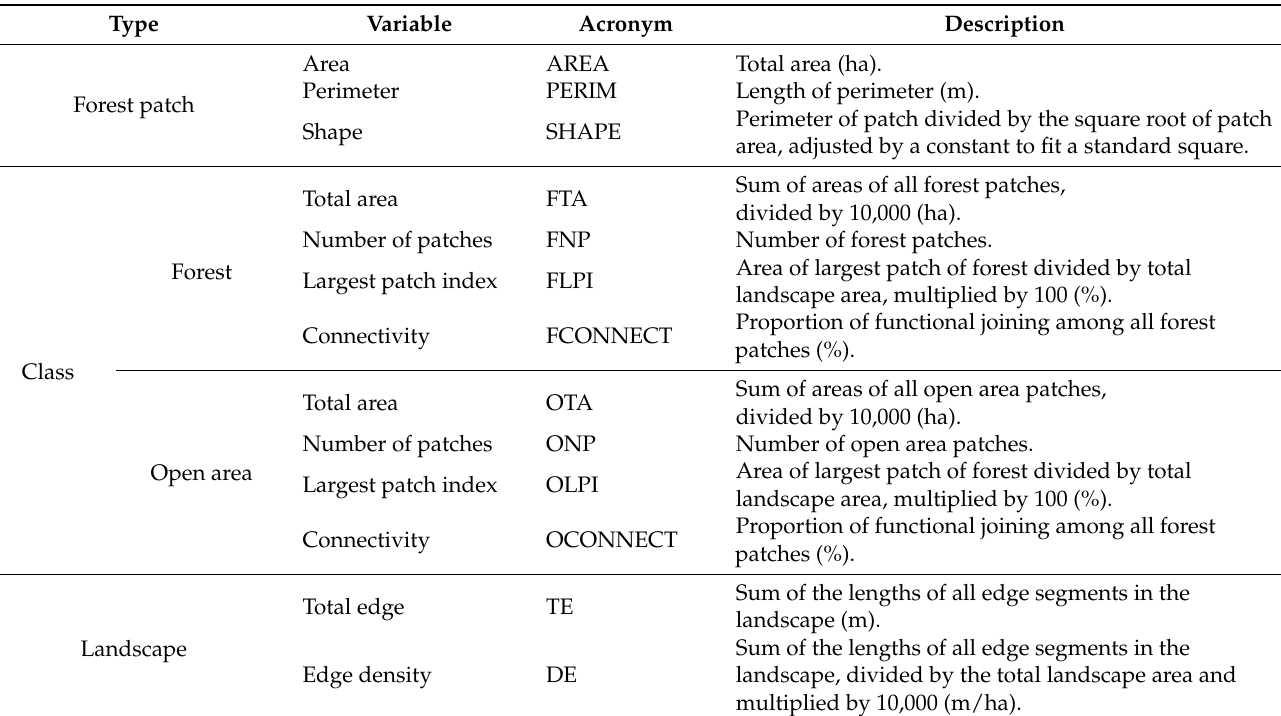
Figure 2. Graphical summary of the methodology to obtain landscape variables of Nothofagus antarctica in Tierra del Fuego, Argentina. Table 1. Description of landscape variables analyzed for Nothofagus antarctica forests in Tierra del Fuego (Argentina).